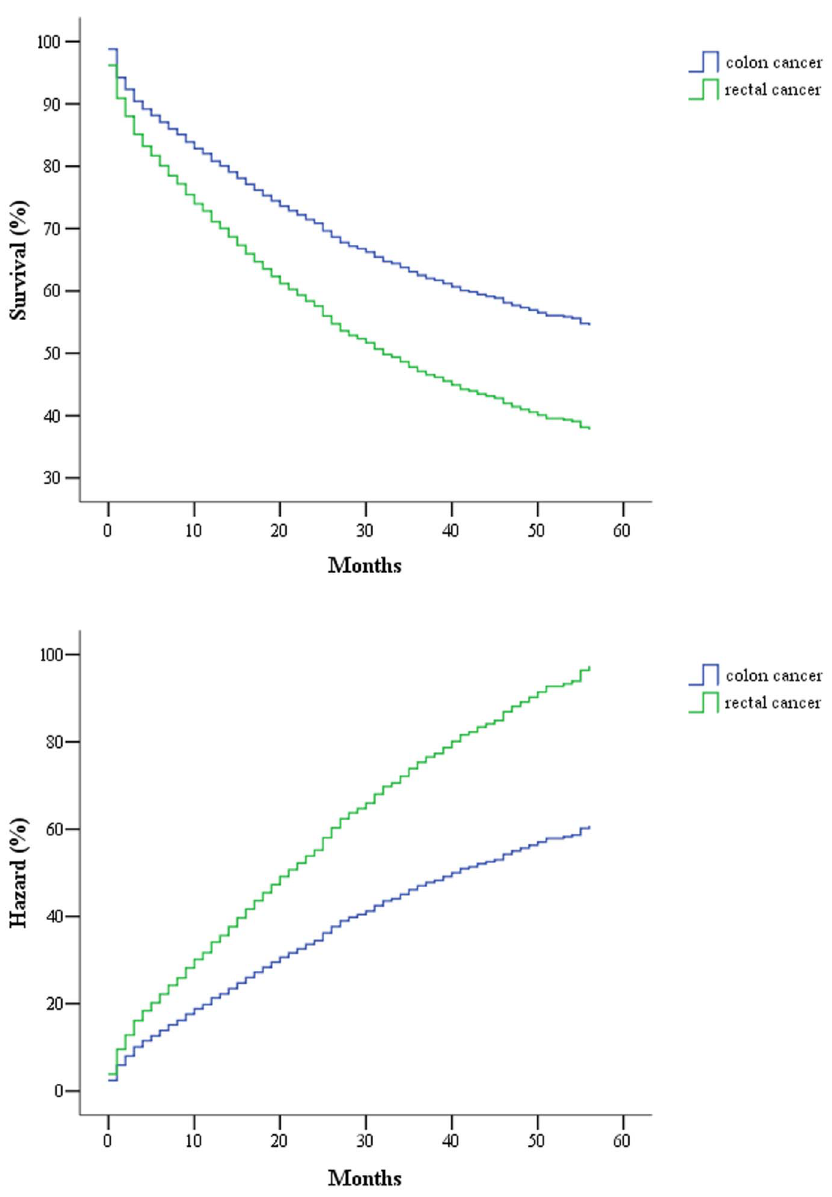
Figure 2. Survival and cumulative hazard in Cox regression model of stage IIB colon and rectal cancer patients.